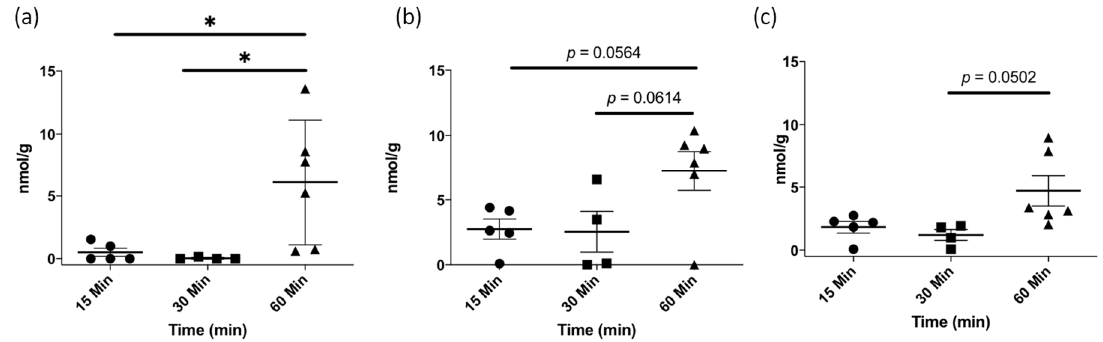
Figure 5. Concentrations of An2-PAPTP-derived metabolites in liver: ( a ) PAPTPL-I; ( b ) PAPTP-IT; ( c ) PAPTP-ITF. Data are expressed as mean ± SEM ( n = 5, 4, and 6 for 15, 30 and 60 min, respectively). *: p < 0.05, One-way ANOVA.